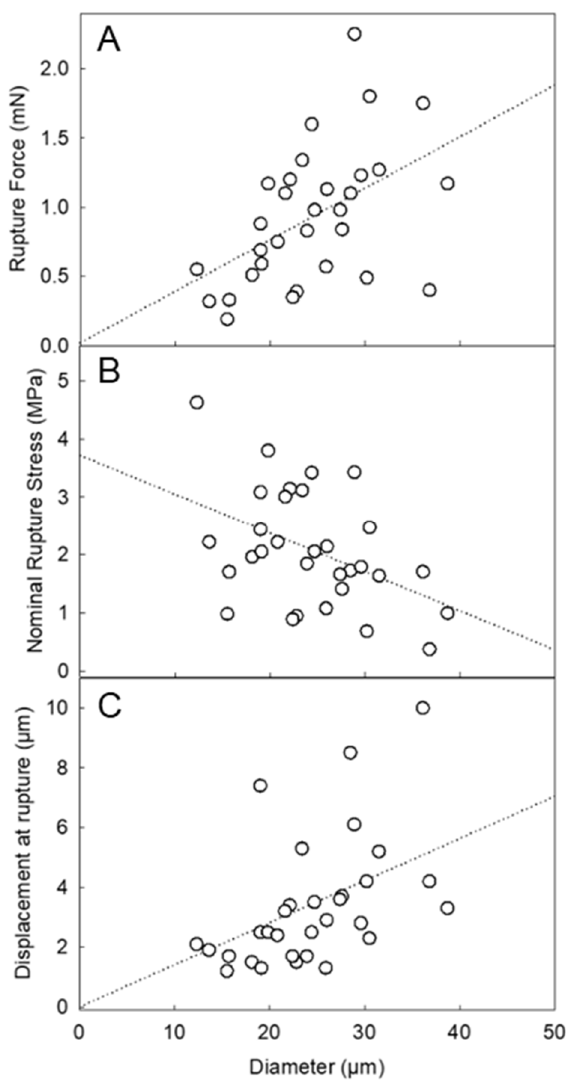
Figure 4. Mechanical property parameters of LM-microcapsules vs. diameter: rupture force ( A ), nominal rupture stress ( B ), and displacement at rupture ( C ). The dotted lines represent the trends only which are simply indicated by a linear fitting of the data in Sigma Plot 14.5 (Alfasoft, Gothenburg, Sweden, EU). Table 1. Key mechanical property parameters of LM microcapsules in comparison with other mi- crocapsules reported in literature (Mean ± St. Error).